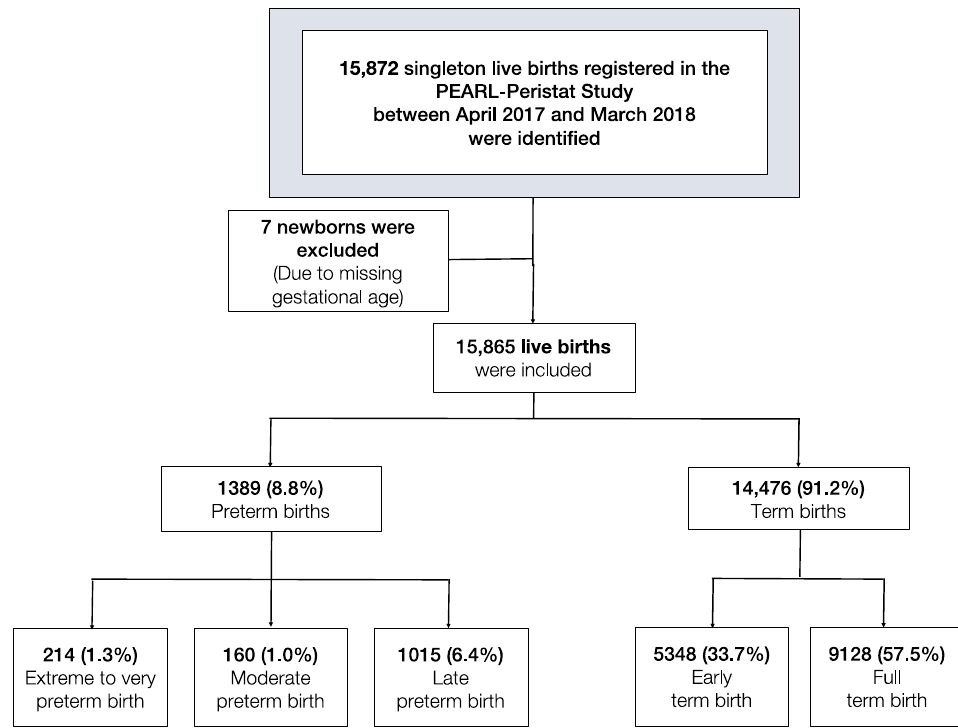
Figure 1. Flow chart of the study live births: term and preterm numbers and percentages.